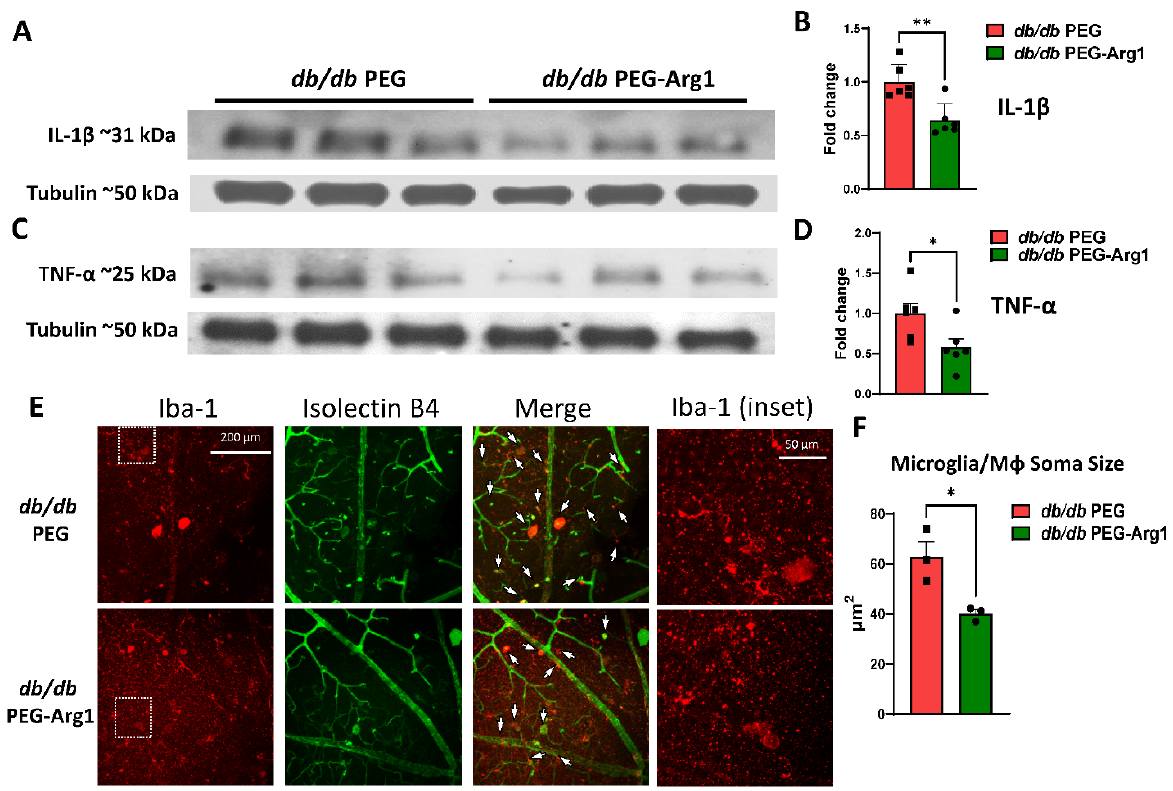
Figure 6. PEG-Arg1 treatment reduced retinal inflammation and reversed M Φ /microglia soma enlargement. ( A , C ) Representative Western blots of the pro-inflammatory cytokines IL-1 β and TNF- α in retinal protein lysates from PEG-A1-treated db/db mice with quantification ( B , D , respectively) compared with the PEG-treated db/db controls (n = 6/group, * p < 0.05, ** p < 0.01). ( E ) Retinal flat- mounts imaged at the level of the superficial vascular plexus labeled with isolectin B4 (vasculature) and Iba-1 (M Φ /microglia) with Iba-1 in the enlarged inset (boxed in white) showing exceptionally enlarged perivascular M Φ /microglia. ( F ) Quantification of M Φ /microglia soma size, demonstrating significant size reductions in the db/db mice treated with PEG-Arg1 compared with the vehicle-treated controls (n = 3 mice/group, * p < 0.05).